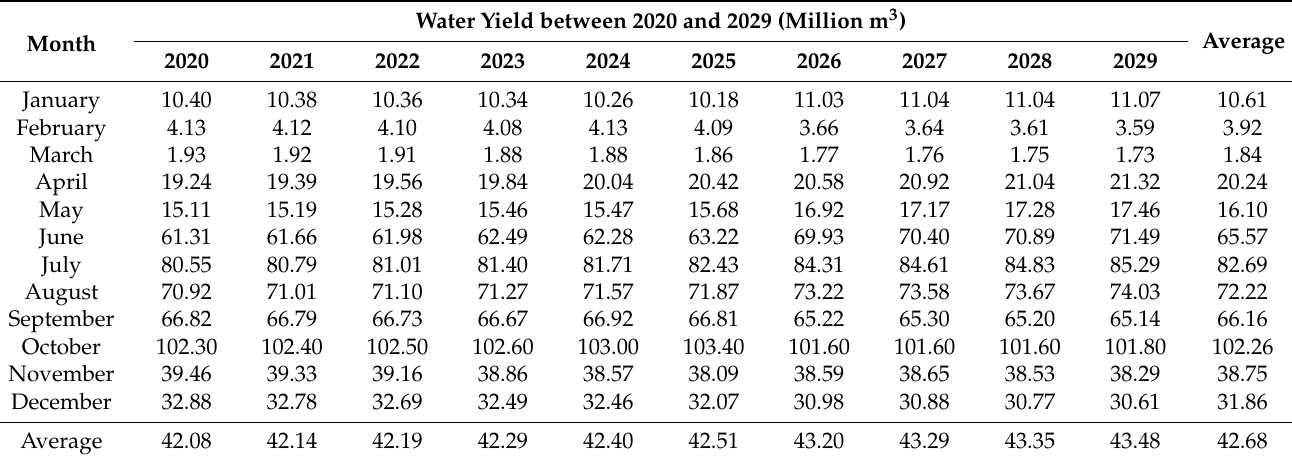
Table 17. Monthly water yield of Phuket Island between 2020 and 2029 under dry year